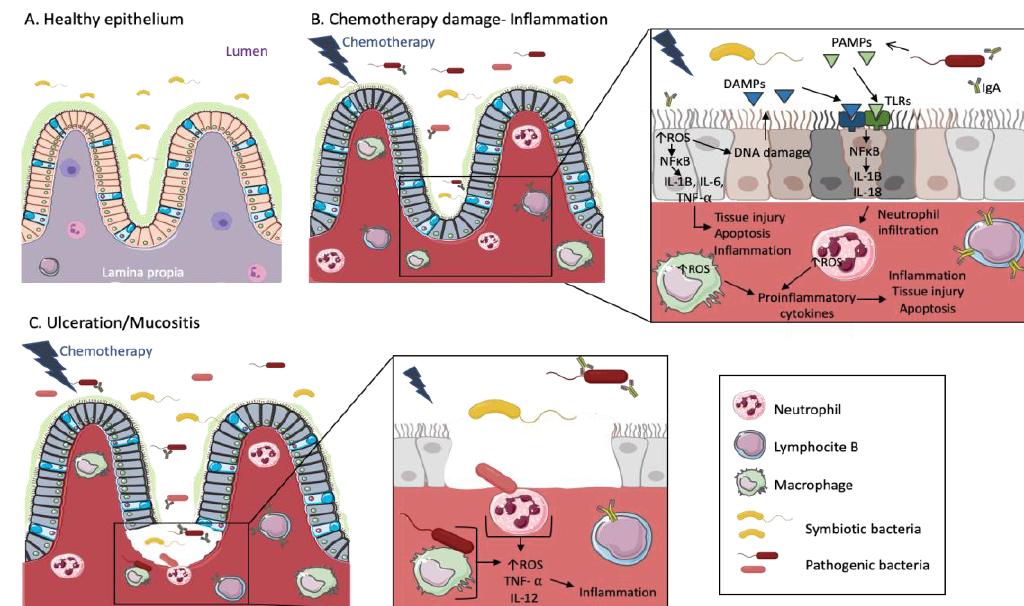
Figure 1. Chemotherapy treatments cause inflammation and mucositis in the intestinal epithelium of cancer patients. The cartoon representing a healthy epithelium ( A ) shows a wide diversity of symbiotic bacteria in the lumen and some inactive immune cells in the lamina propia. Both spaces are separated by a mucosal barrier. When patients are treated with chemotherapy ( B ), the mucosal barrier is damaged and pathogenic bacteria coexist with symbiotic bacteria in gut microbiota. Then, intestinal epithelial cells suffer DNA damage and tissue injury/cell apoptosis mediated by the increase of Reactive Oxygen Species (ROS) and cytokines signaling cascades. Cells affected by DNA damage release Damage-Associated Molecular Patterns (DAMPs), which together with Pathogen-Associated Molecular Patterns (PAMPs) released by pathogenic bacteria, are recognized by Toll-like receptors (TLRs). This signal is transmitted by the NFκB pathway, leading to the release of cytokines such as IL-1B, which enhance neutrophil/macrophage infiltration. ROS levels are increased in macrophages and neutrophils producing proinflammatory cytokines, tissue injury and apoptosis. On the other hand, B-lymphocytes produce IgA against the pathogenic bacteria. When the mucosal barrier is broken and the tissue injury advances ( C ), pathogenic bacteria interact with immune cells, increasing ROS production and provoking the activation of TNF- α as well as cytokines production, such as